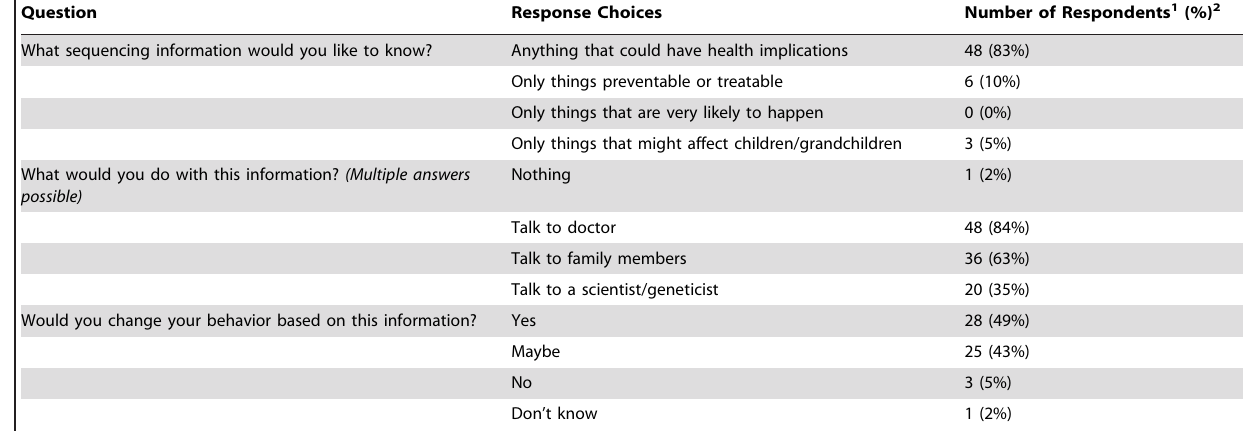
Table 2. Highlighted survey